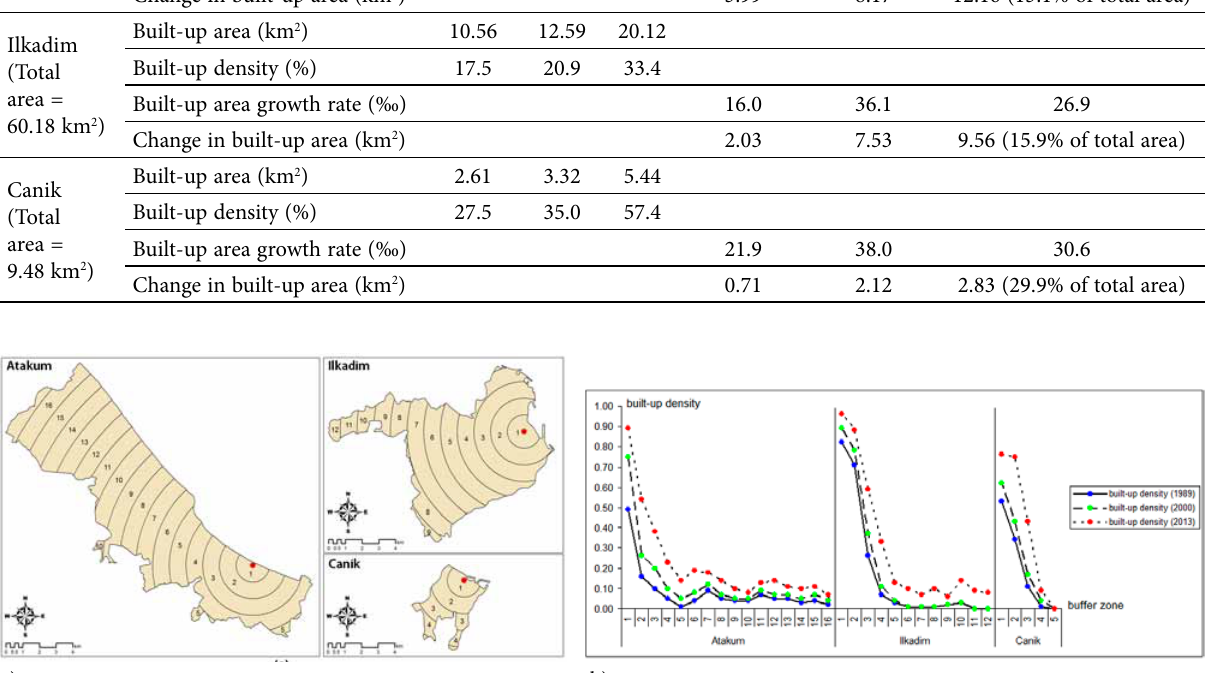
a) Fig. 4. (a) Circular buffer zones created by the 1-km intervals from the centers of Atakum, Ilkadim and Canik. (b) The changes in the built-up density over time in each buffer zone in Atakum, Ilkadim and Canik